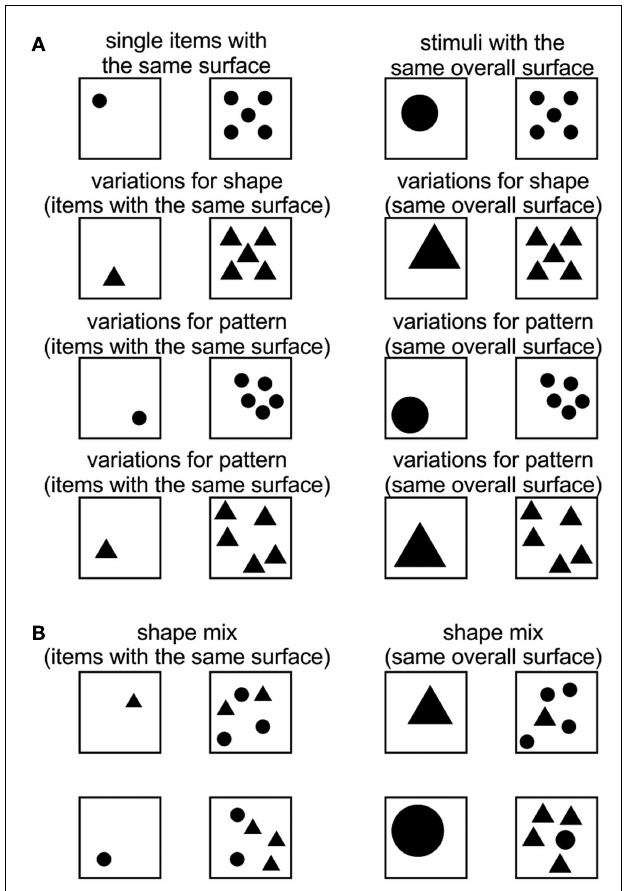
FIGURE 2 | (A) Examples of the stimulus pair 1 vs. 5 with variations of surface, size, shape, and pattern of elements. Similar conditions were also used for 1 vs. 4, 1 vs. 3, and 1 vs. 2; (B) examples of control stimuli for 1 vs. 5. Similar conditions were presented for 1 vs. 4, 1 vs. 3, and 1 vs.